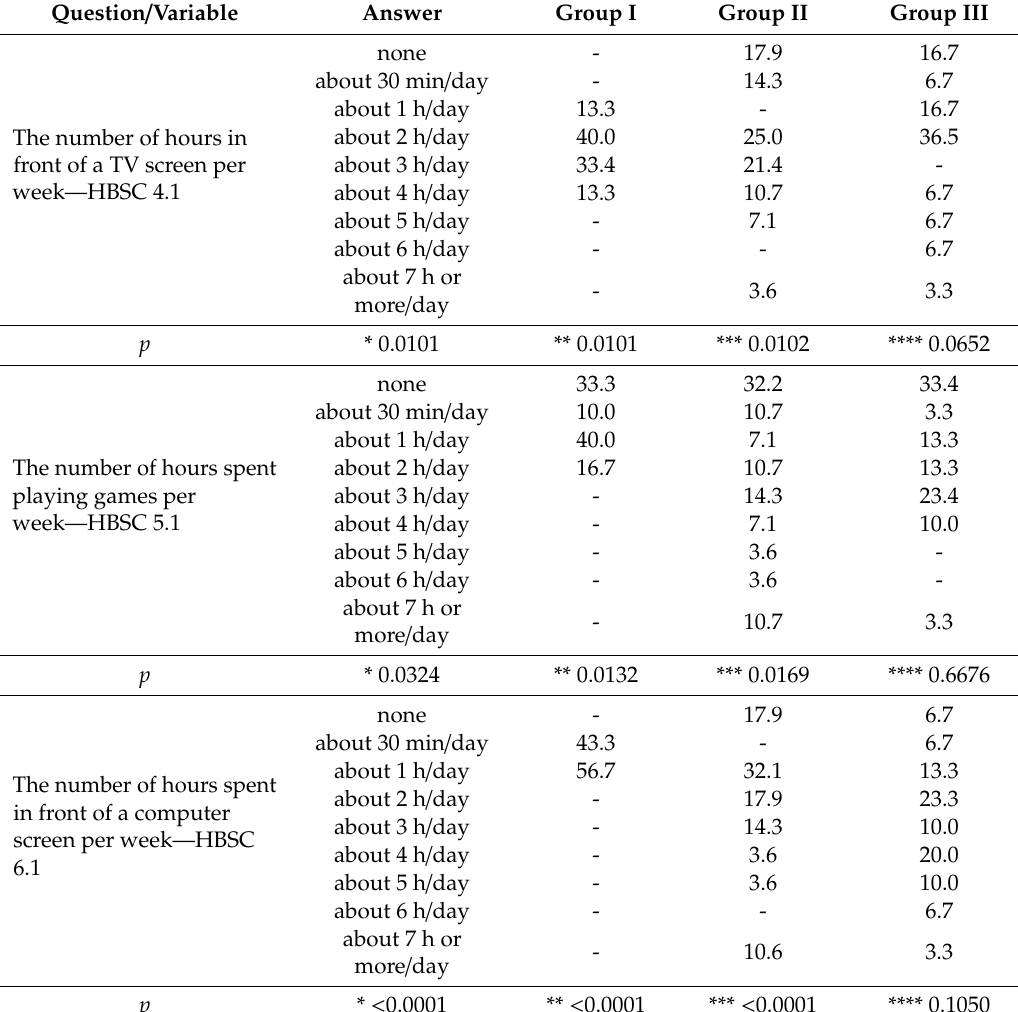
Table 4. Time spent in front of a computer / TV screen per week. The percentage of respondents providing a given answer